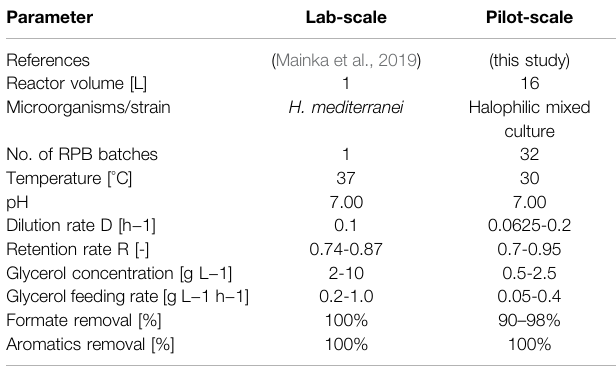
TABLE 2 | Comparison of scale-up